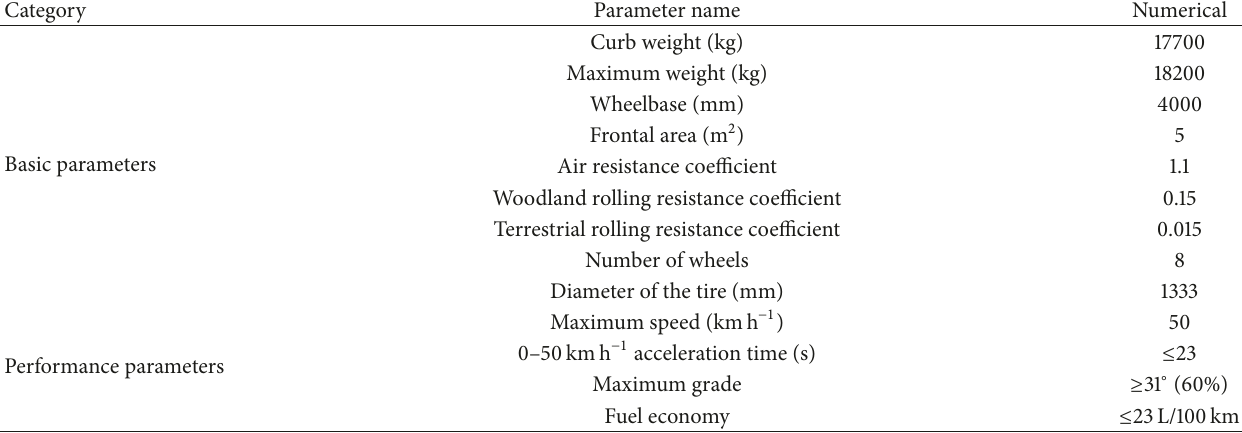
Table 1: The basic parameters and performance indicators of CFJ20H hybrid power harvester.